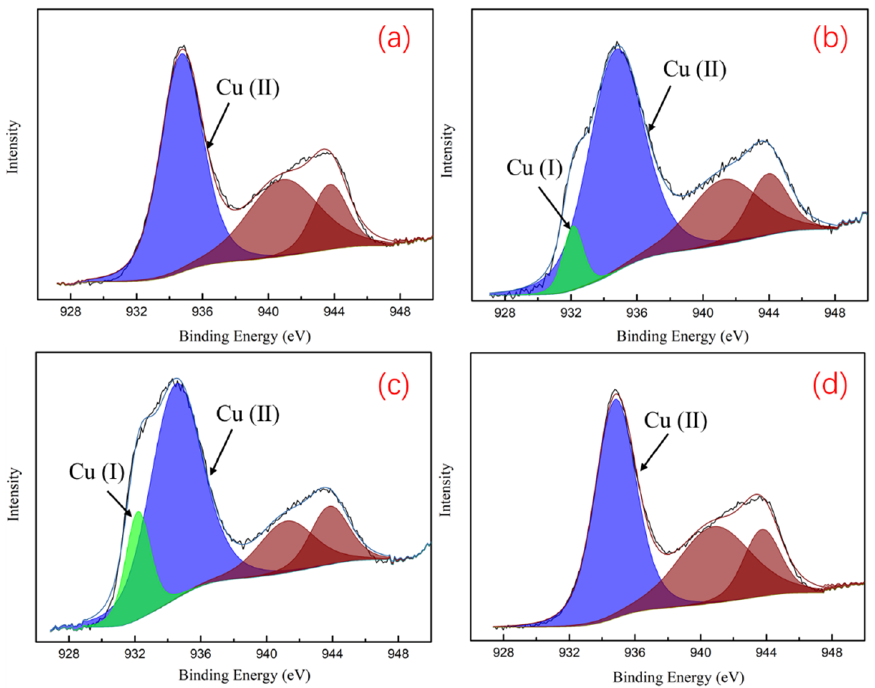
Figure 10. Cu 2p XPS spectra of ( a ) raw malachite, ( b ) malachite treated with Na 2 S, ( c ) malachite treated with LA and Na 2 S, ( d ) malachite treated with LA ( c (LA) = 6.0 × 10 − 5 mol/L; c (Na 2 S) = 3.0 × 10 − 3 mol/L; pH = 9.6).